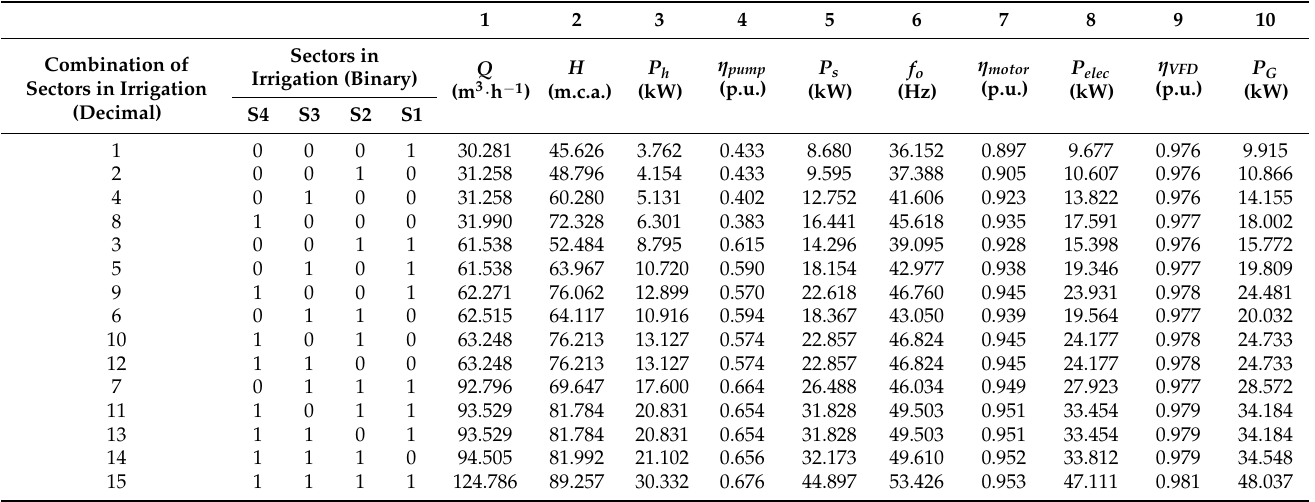
Table 9. Demand matrix of the irrigation network for the combinations of 4